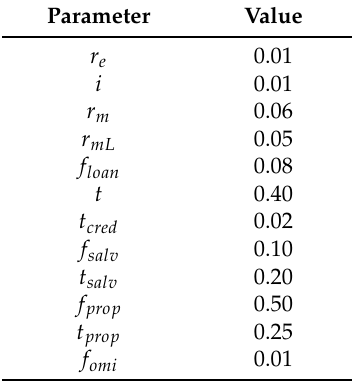
Table 3. Input cost factor values.